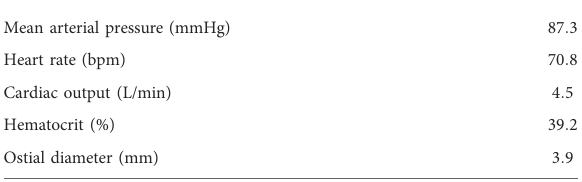
FFR semi (cid:1) streamlined , which was identical to FFR baseline . As for FFR streamlined , the sensitivity was 79.0% (95% CI: 54.4 – 94.0%), speci fi city was 90.3% (95% CI: 74.3 – 98.0%), and overall